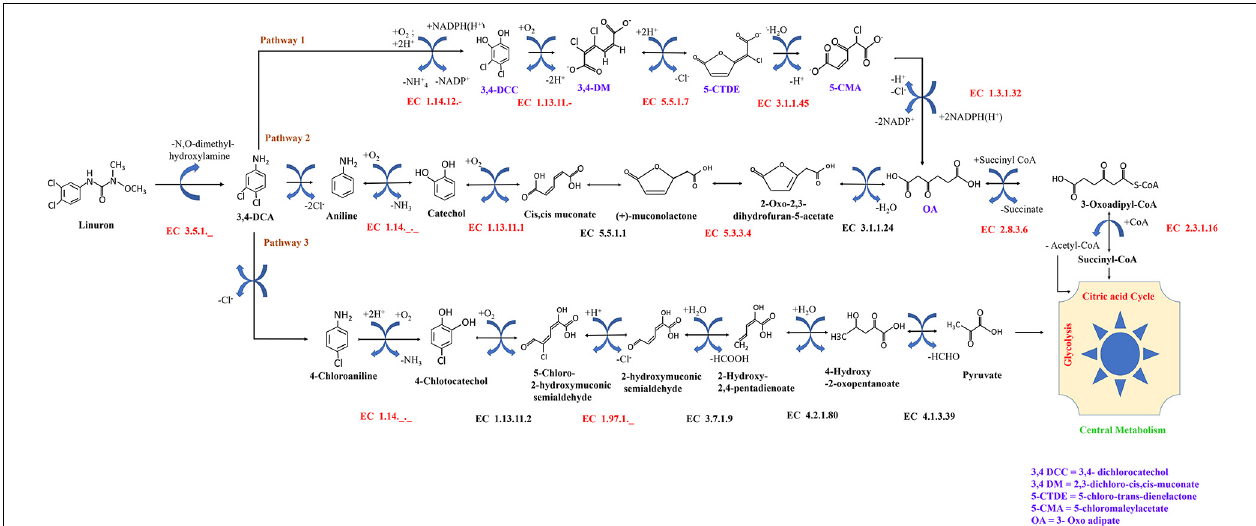
FIGURE 1 | Possible fate of linuron and 3,4-DCA in SRS 16. Reactions in black were included in the automatic reconstruction. Reactions in red were manually added to the model. Pathway 1 (modified ortho-cleavage pathway) was retrieved from BioCyc based on direct evidence for Variovorax SRS 16 strain (https://biocyc.org/META/NEW-IMAGE?type=PATHWAY&object=PWY-7496). Pathways 2 and 3 (ortho- and meta-cleavage pathways, respectively) were completed by following the generic KEGG pathways.